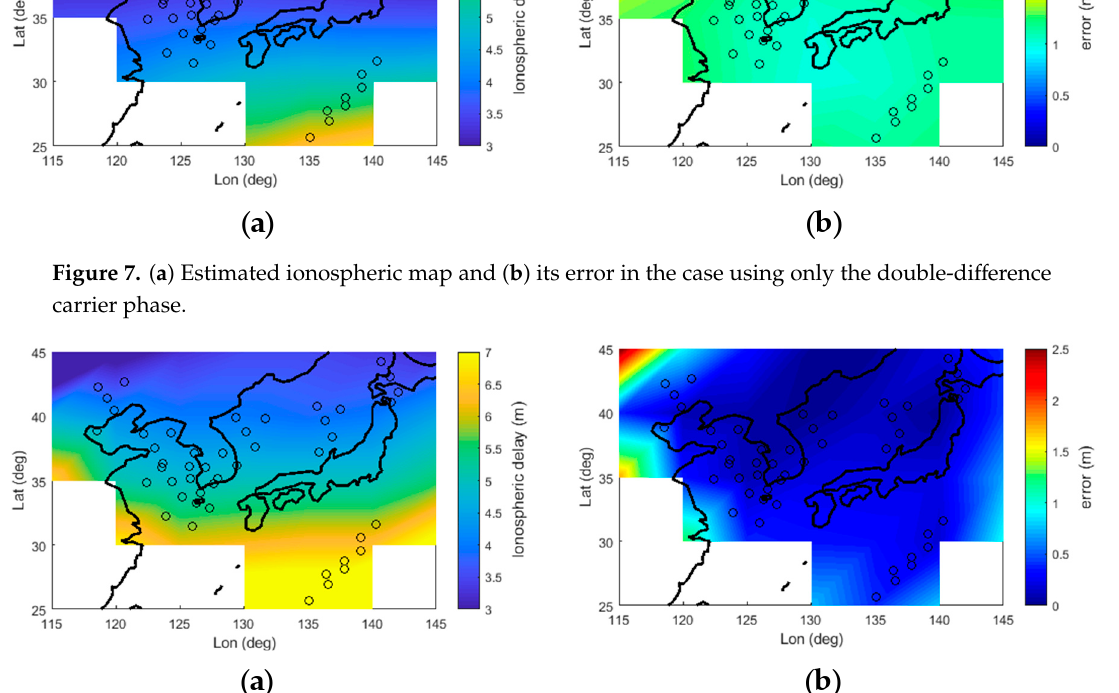
Figure 8. ( a ) Estimated ionospheric map and ( b ) its error in the case using both the pseudorange and double-difference carrier phase.